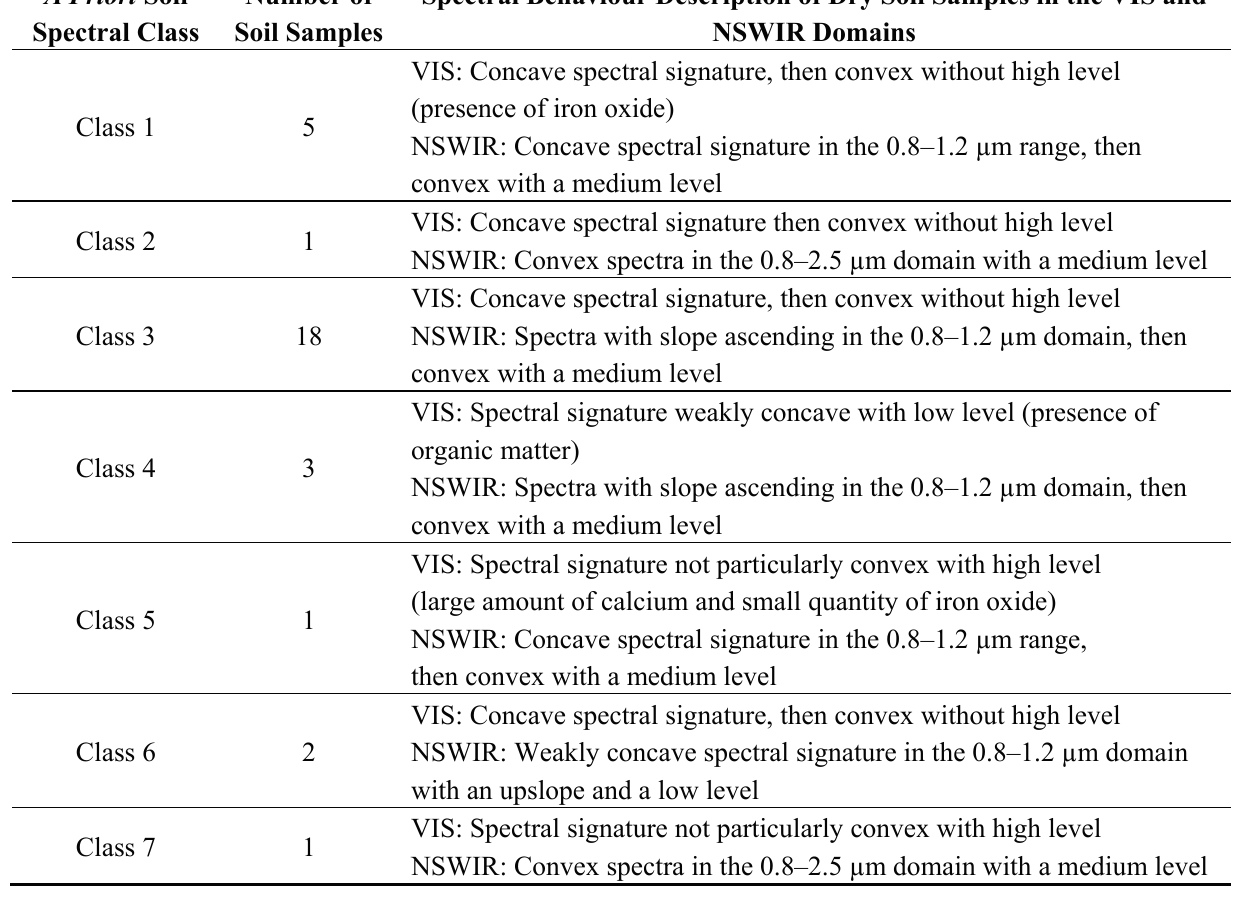
Table 2. The a priori spectral classification of the dry soil samples.